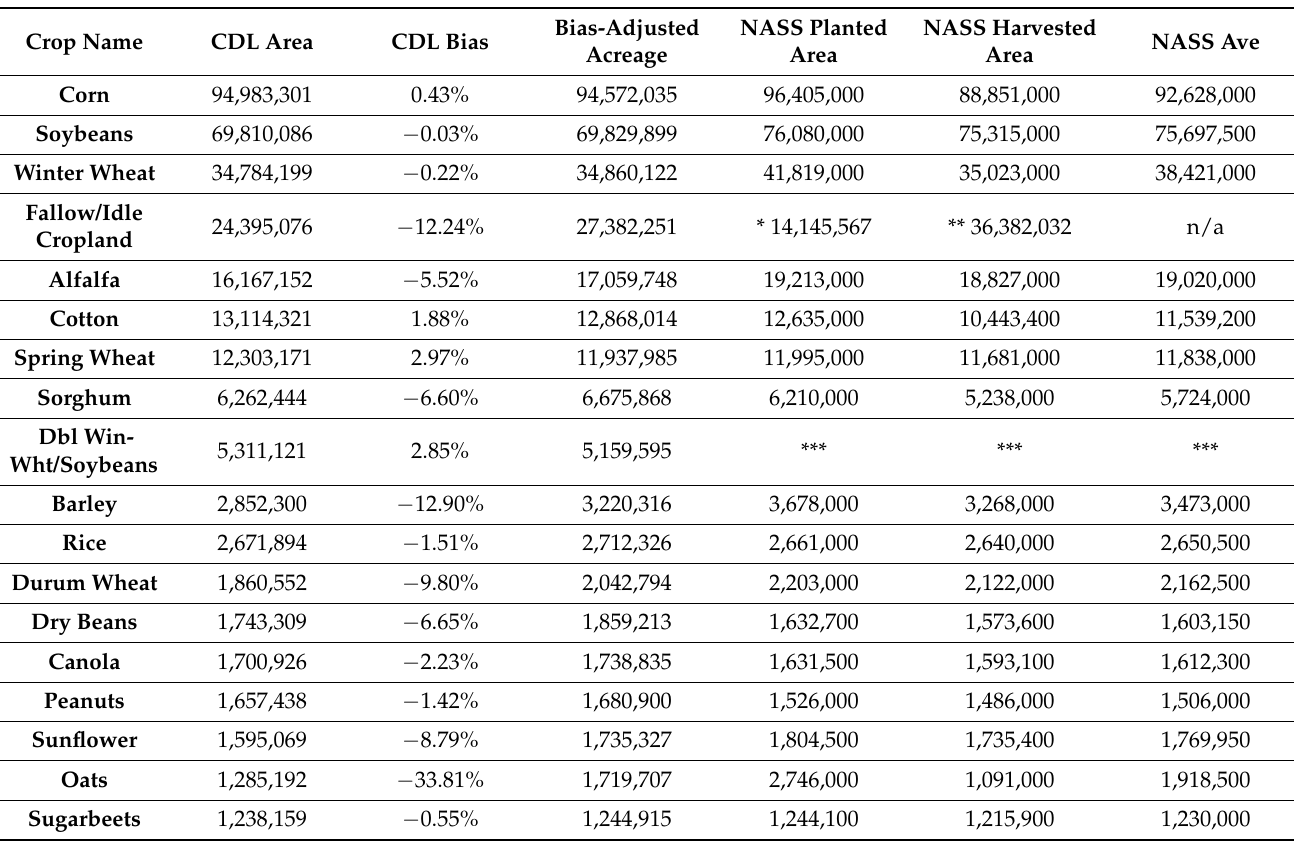
Table 6. Simple bias and bias-adjusted acreage estimates for major crops for 2012. CDL area represents the summed area of all pixels in the CDL. CDL bias and bias-adjusted acreage were calculated for each crop according to Equations (12) and (13) using the producer’s and user’s accuracy data of Appendix A Table A2. NASS planted and harvested areas are from the annual NASS acreage report, released on June 29, 2012. Harvested cotton from 2012 October production report. All area values are reported in